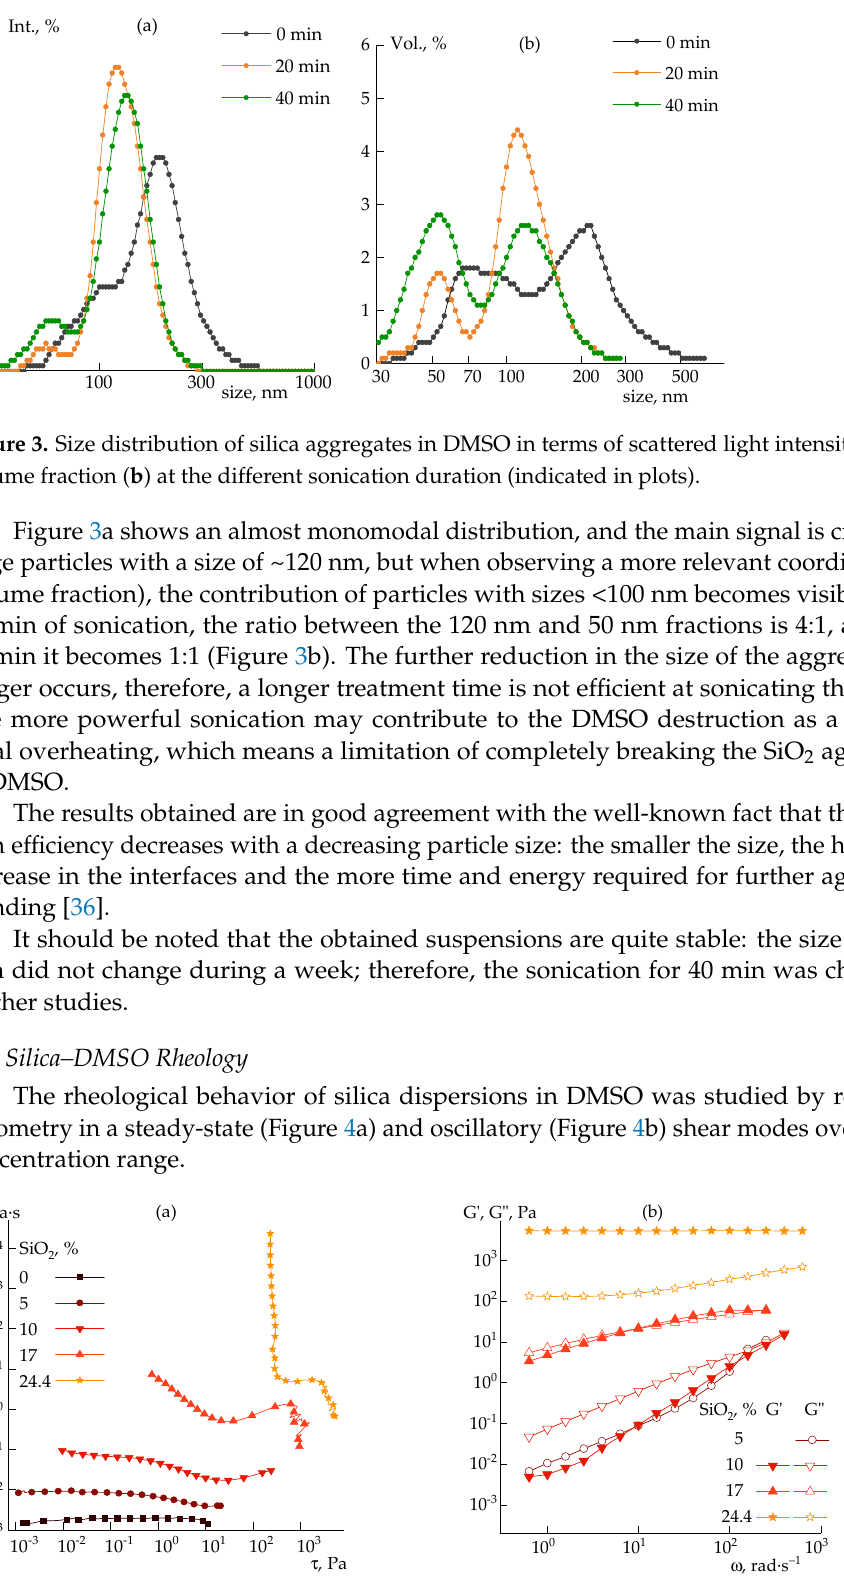
Figure 4. Flow curves ( a ) and frequency dependences of storage and loss moduli ( b ) for silica–DMSO suspensions of different concentrations (indicated in plots).